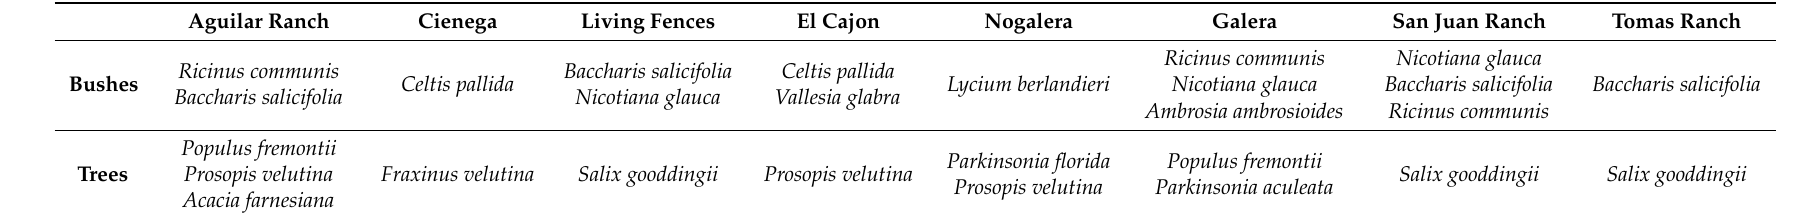
Table 6. Dominant bush and tree species by number of individuals in Riparian Vegetation stands for each site.